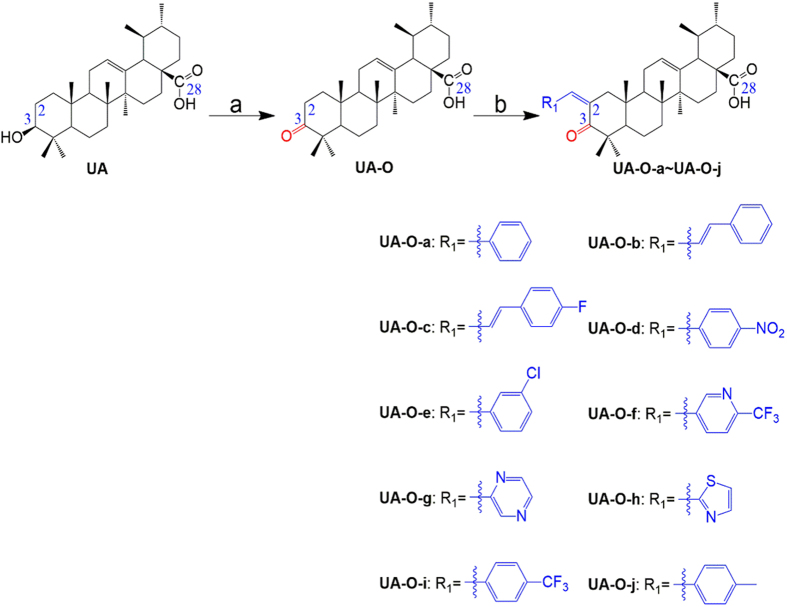
Synthesis of analogues UA-O-a~UA-O-j from UA.Reagent and condition: (a) CrO3, H2SO4, acetone, 0 °C, 1 h; (b) R1-CHO, KOH, ethanol, r.t., overnight.